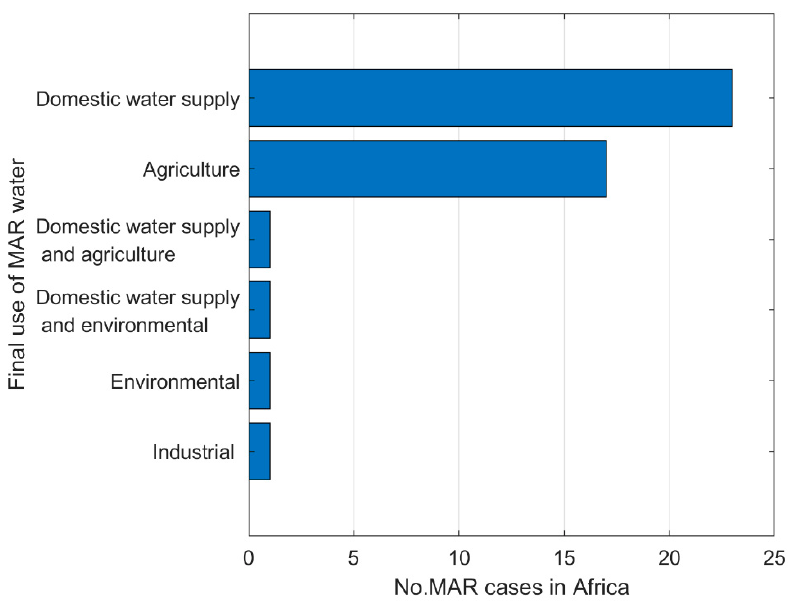
Figure 9. Number of MAR cases in Africa per final water use of stored water where information is available (n = 44).